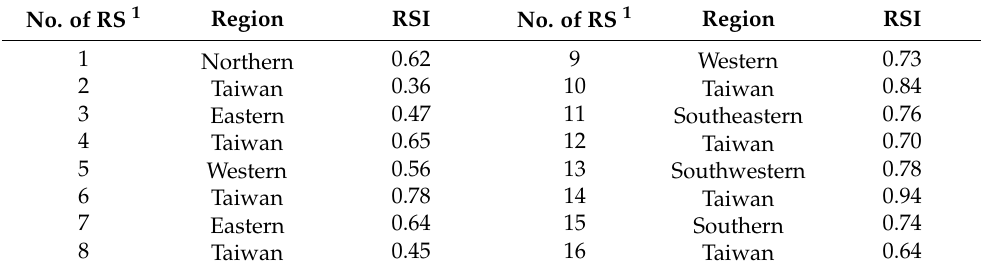
Table 2. The rainfall seasonality index value in each region in Taiwan from